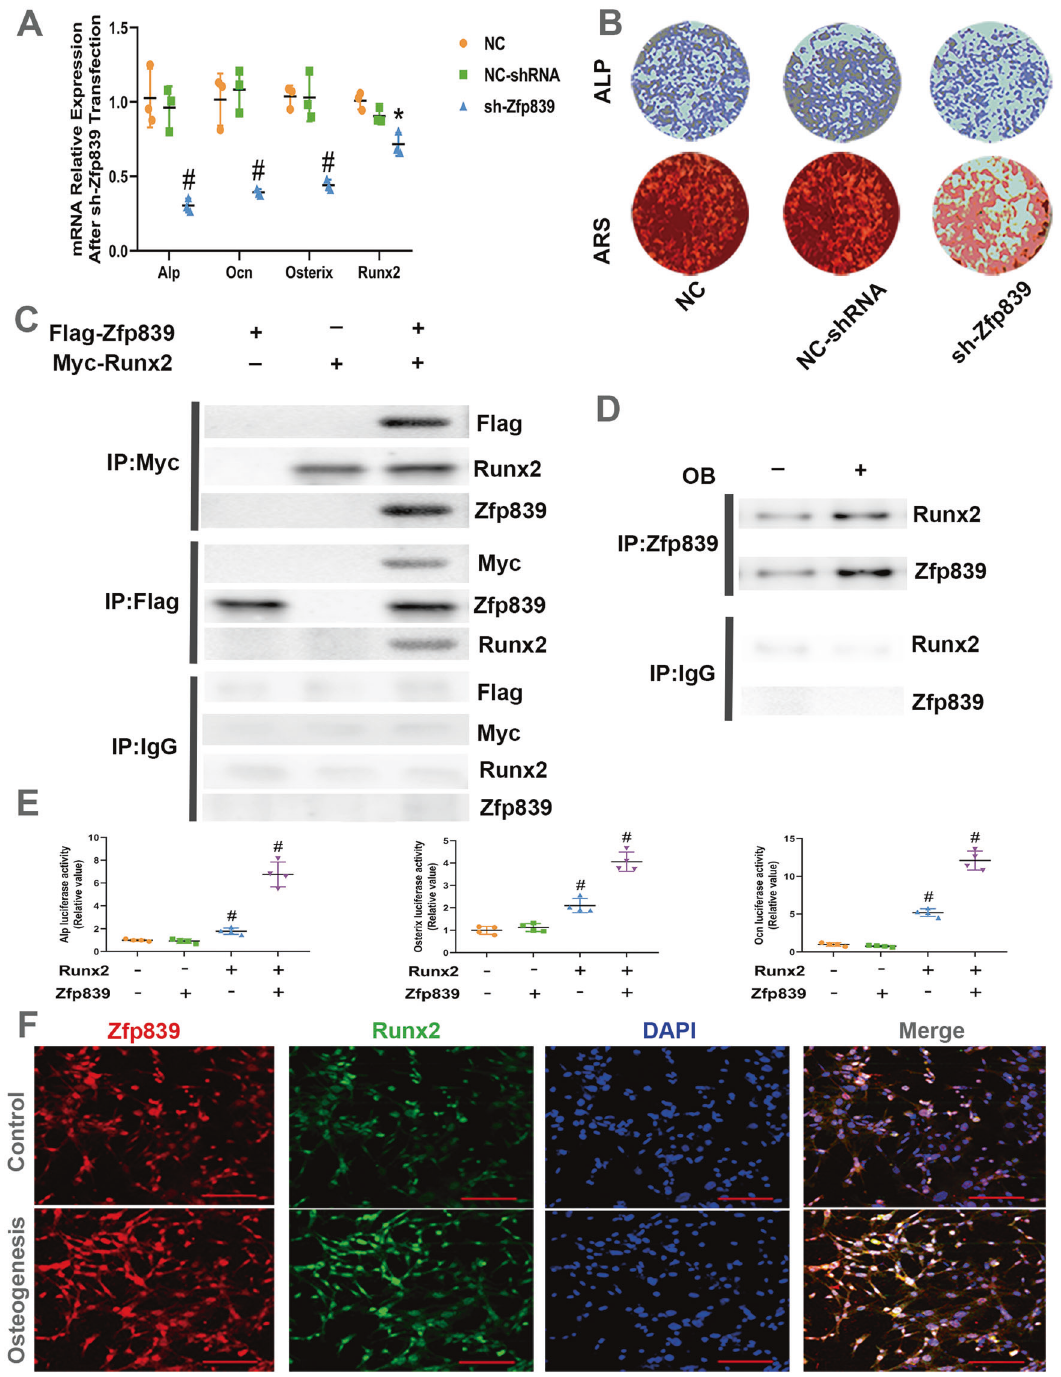
Fig. 5 Zfp839 enhanced BMSC osteogenesis via physical interaction with Runx2. A mRNA expression levels of Ocn, ALP, Osterix, and Runx2 detected 72 h after osteogenic induction, *P < 0.05, # P < 0.01 versus NC or NC-shRNA samples. B ALP and Alizarin Red staining were performed to detect the osteogenesis of mouse BMSCs. C 293 T cells were transfected with Myc-Runx2 and Flag-Zfp839. Cell lysates were immunoprecipitated with Myc or Flag Abs and then subjected to Western blot analysis with Flag, Myc, Zfp839, or Runx2 Abs. D Cell lysates from MC3T3-E1 cells that were subjected to 3 days osteoblastic induction (OB) were immunoprecipitated with the Zfp839 Ab followed by Western blot analysis with the Runx2 Ab. E Zfp839 promoted Runx2 transcriptional activity in 293 T cells. 293 T cells were overexpressed with Zfp839 or Runx2 and transfected with the Alp, Osterix, or Ocn luciferase vector. Luciferase activities of Alp, Osterix, and Ocn were detected. All experiments were independently performed in triplicate. Data are presented as the mean ± SD ( n = 4). (Paired t test, n = 4, *P < 0.05 and # P < 0.01). F Immuno fl uorescence staining for Zfp839 and Runx2 in BMSC osteogenesis induction for 72 h or control cells. Scale bar = 50